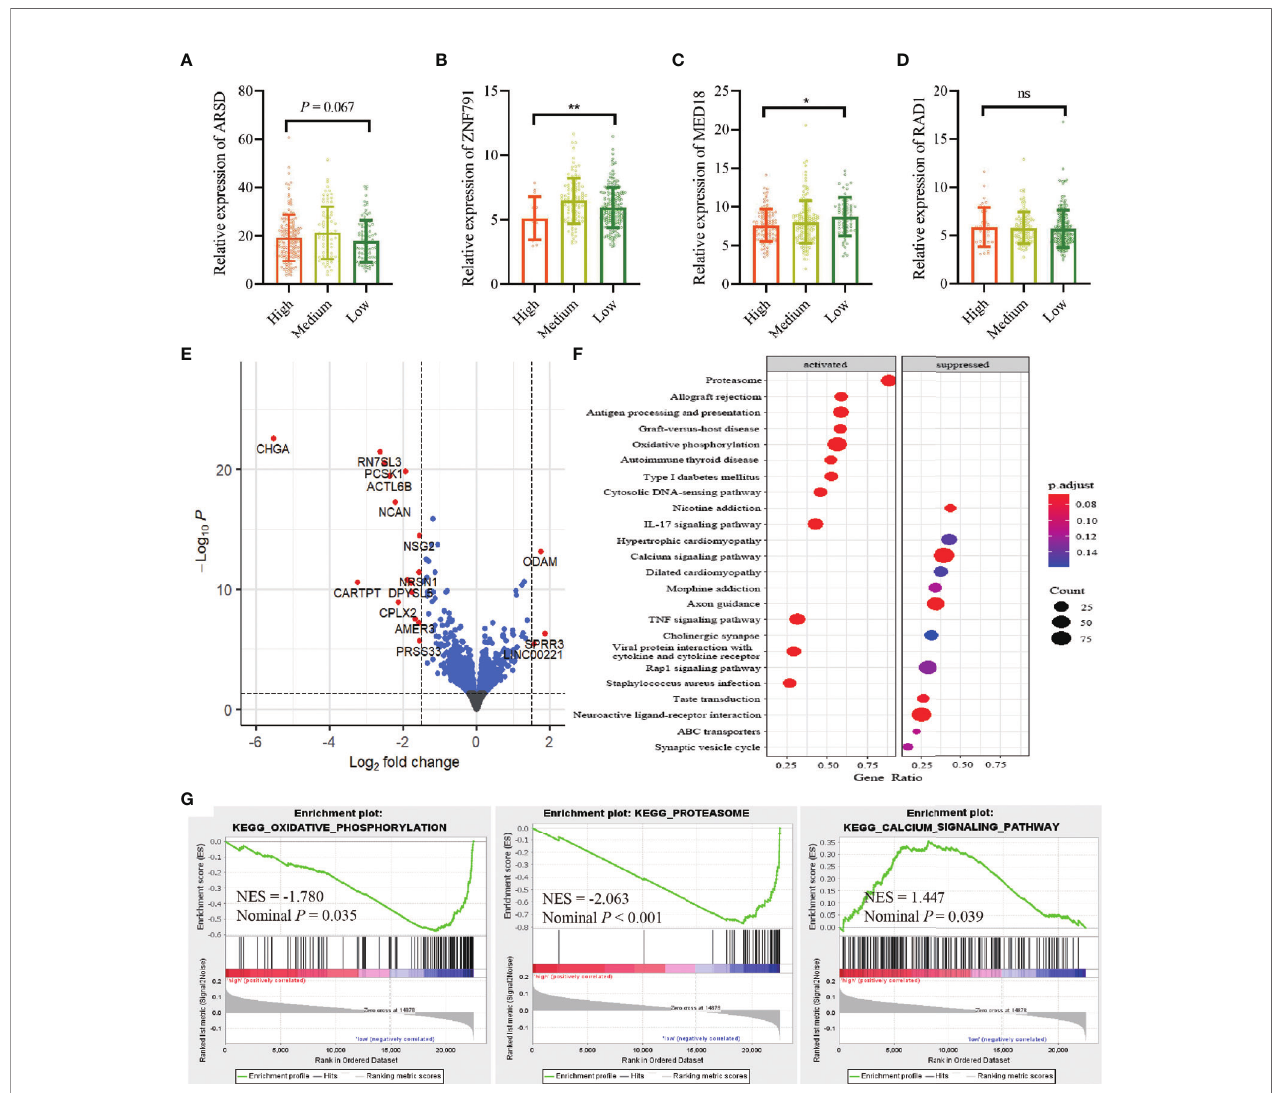
FIGURE 5 | Correlation between the AIRS sites and gene expressions. (A – D) Correlations between editing levels of the four AIRS sites and expression levels of host genes. Data are presented as mean ± SD, and p -values are calculated by the one-way ANOVA test. * p < 0.05,** p < 0.01, ns, not signi fi cant. (E) Visualization of differentially expressed genes with volcano plot in high AIRS patients versus low AIRS patients. The expression difference of a log 2 fold change of 1.5 (outer light gray broken vertical line) and for an adjusted p -value of 0.05 (dark broken horizontal line). y-Axis refers to p -values in – log10 scale, and x-axis refers to the fold change in log 2 scale. (F) Plot of the KEGG pathway enrichment analysis for AIRS-related genes based on TCGA data. y-Axis represents pathways; x-axis represents the amount of AIRS-related genes enriched in KEGG pathways. The color and size of each bubble represent enrichment signi fi cance and the number of AIRS-related genes enriched in KEGG, respectively. (G) GSEA enrichment plot of KEGG pathway genes in high AIRS versus low AIRS. KEGG, Kyoto Encyclopedia of Genes and Genomes; GSEA, Gene Set Enrichment Analysis; NES, normalized enrichment score; AIRS, adenosine-to-inosine RNA editing-based risk score; TCGA, The Cancer Genome